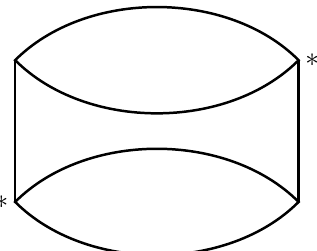
Figure 3 . Sunset diagrams are the diagrammatic representation of the contractions depicted in (3.9). Each vertex of the diagram represents an insertion of a OPE coefficient. The ones corresponding to the insertions of c ∗ s are marked with a star, while the unmarked vertices are the c insertions. Each edge in the diagram corresponds to the index contractions between OPE